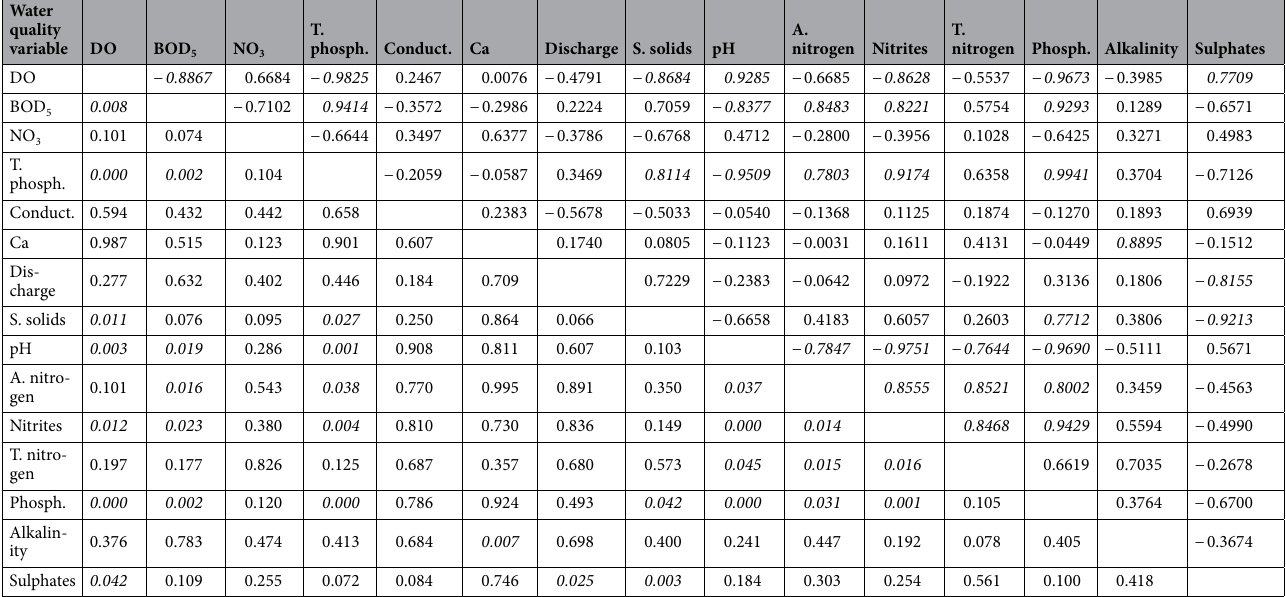
Table 2. Pearson correlation coefficients (half of the table above the diagonal) between the values of environmental variables measured in the recovered course of the Ner River, Poland, in the fish sampling period, and significance values of these correlation coefficients (half of the table below the diagonal). The number of values was 7 in all variables, degrees of freedom were 5 in all tests. Statistically significant values are in italic font. Abbreviations of environmental variables’ names: DO dissolved oxygen, BOD 5 biological oxygen demand, NO 3 nitrates, T. phosph. total phosphorus, Conduct. conductivity, Ca calcium, Discharge discharge, S. solids suspended solids, pH pH, A. nitrogen ammonia nitrogen, Nitrites nitrites, T. nitrogen total nitrogen, Phosph. phosphates, Alkalinity alkalinity, Sulphates